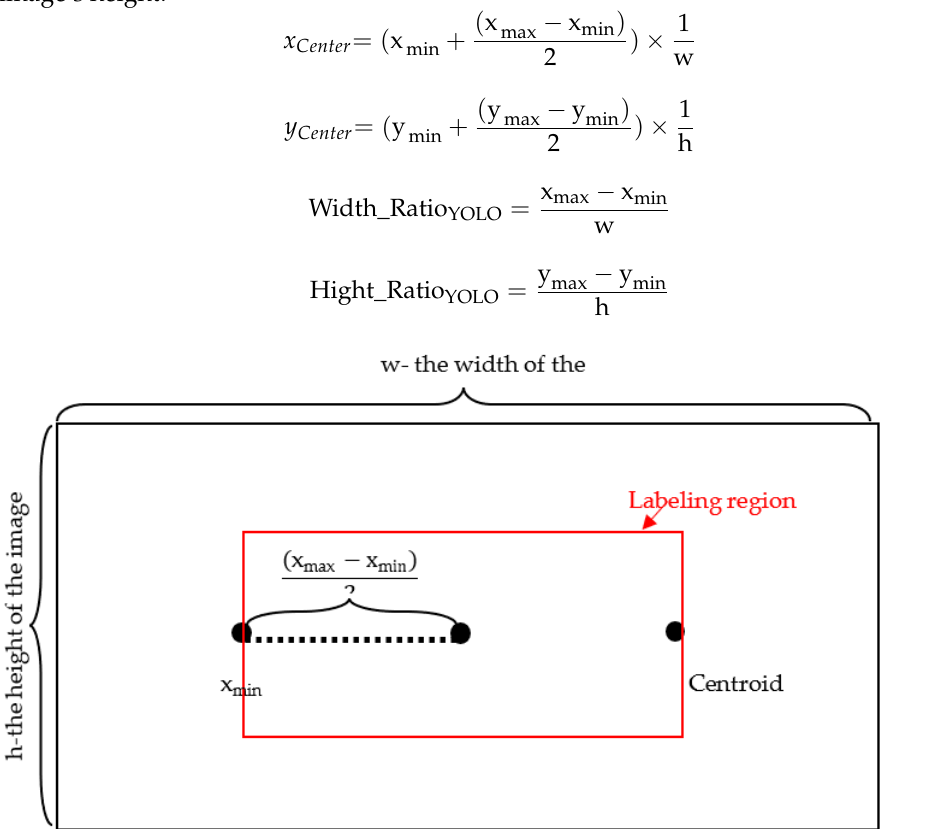
Figure 3. The image and labeling region.